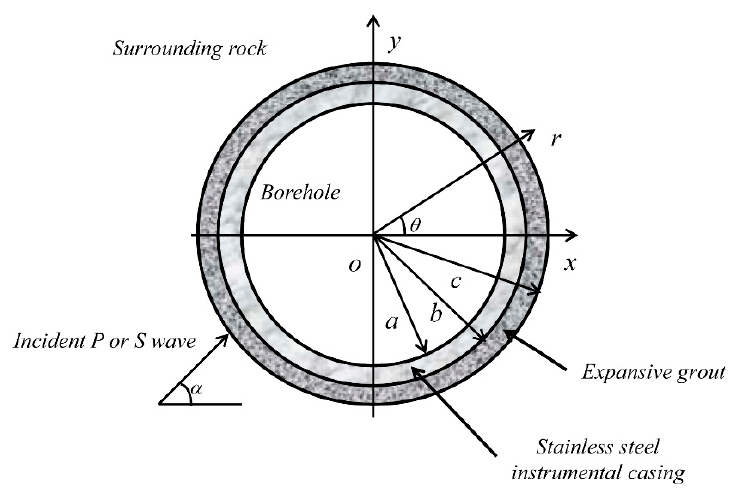
Figure 1. The scattering model of the incident elastic plane wave by a two-ring